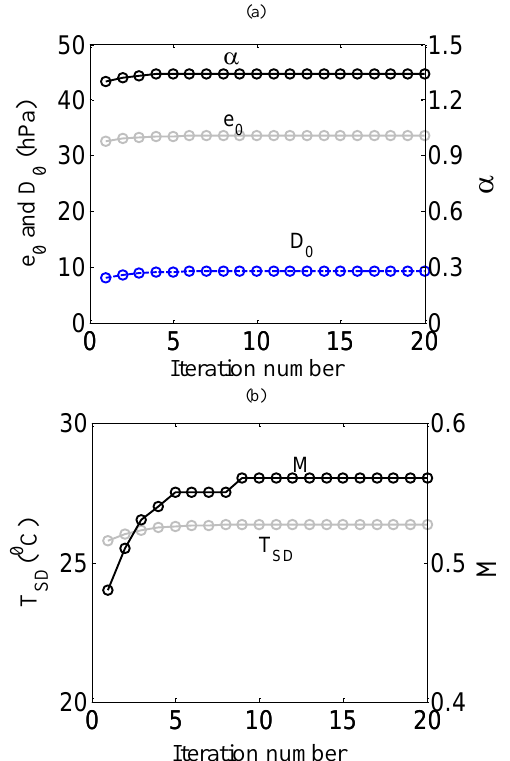
Figure A3. (a) Convergence of the iteration method for retrieving the source/sink height (or in-canopy) vapor pressures ( e 0 and D 0 ) and Priestley–Taylor coefficient ( α ). (b) Convergence of the itera- tion method for retrieving the surface wetness ( M ) and source/sink height dew-point temperature ( T SD ). The initial values of λE,g A , g C , and T 0 were determined with α = 1.26. The process is then iter- ated by updating λE , e 0 , D 0 , M , T SD , and α in subsequent iterations with the previous estimates of g A , g C , and T 0 .